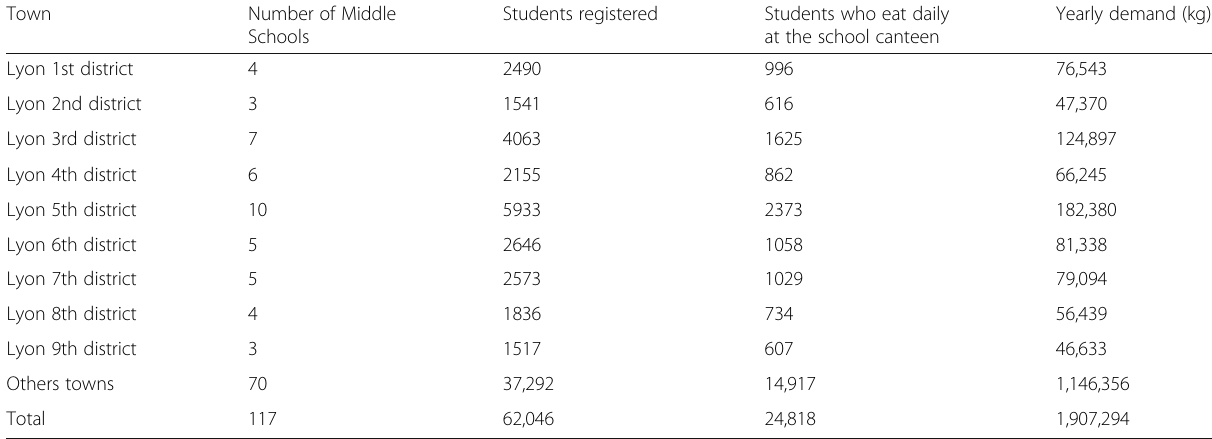
Table 2 Yearly demand estimation and number of consumers per Lyon ’ s district and other towns of the Great Lyon